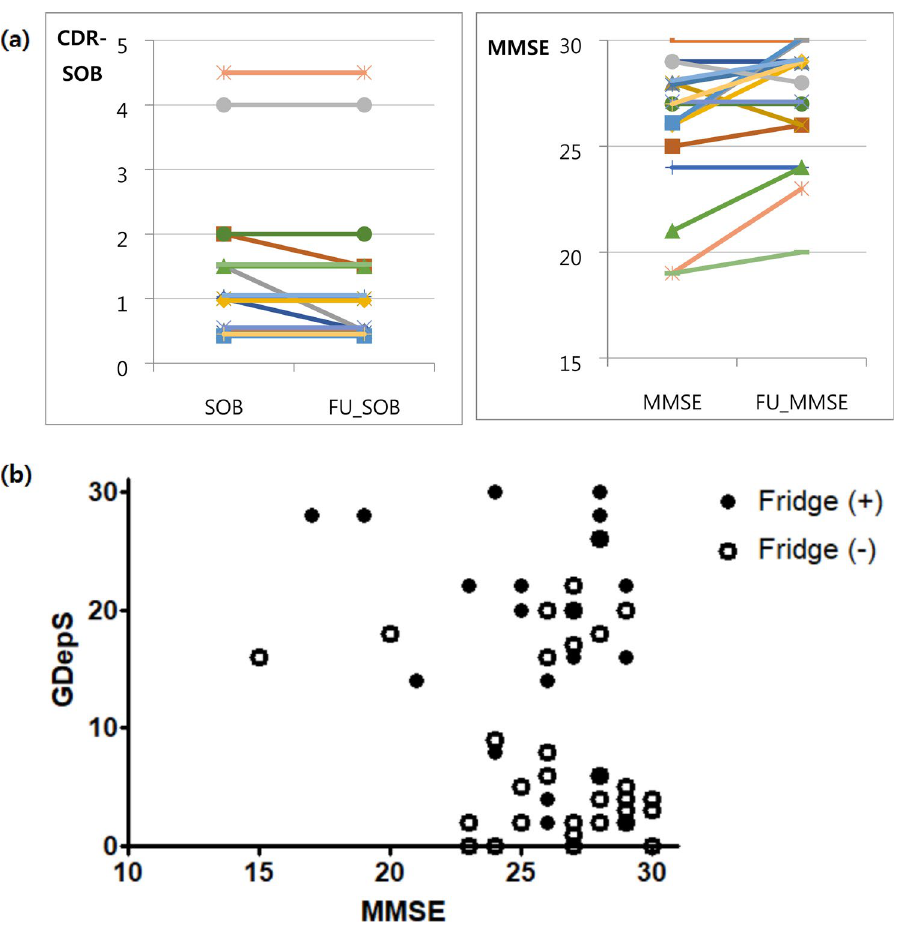
Figure 2. ( a ) Initial and follow-up neuropsychological tests of fifteen patients. ( b ) Distribution of MMSE and Geriatric Depression Scale of MCI patients according to the presence of the fridge sign. CDR-SOB Clinical dementia rating-sum of box, MMSE Mini-Mental State Examination, GDepS Geriatric Depression Scale. The ( a ) was generated using Microsoft Excel 2013 (https ://www.micro soft.com) and the ( b ) was generated with GraphPad Prism version 5.01 (https ://www.graph